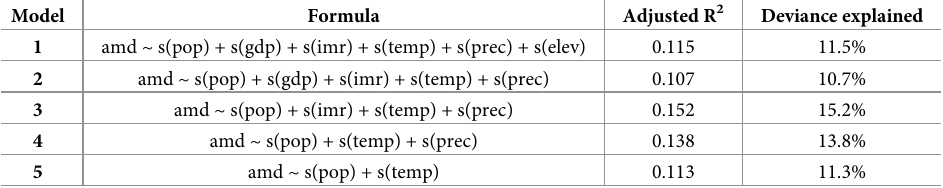
Table 3. Results of Generalized Additive Model (GAM). Family: gaussian; link function: